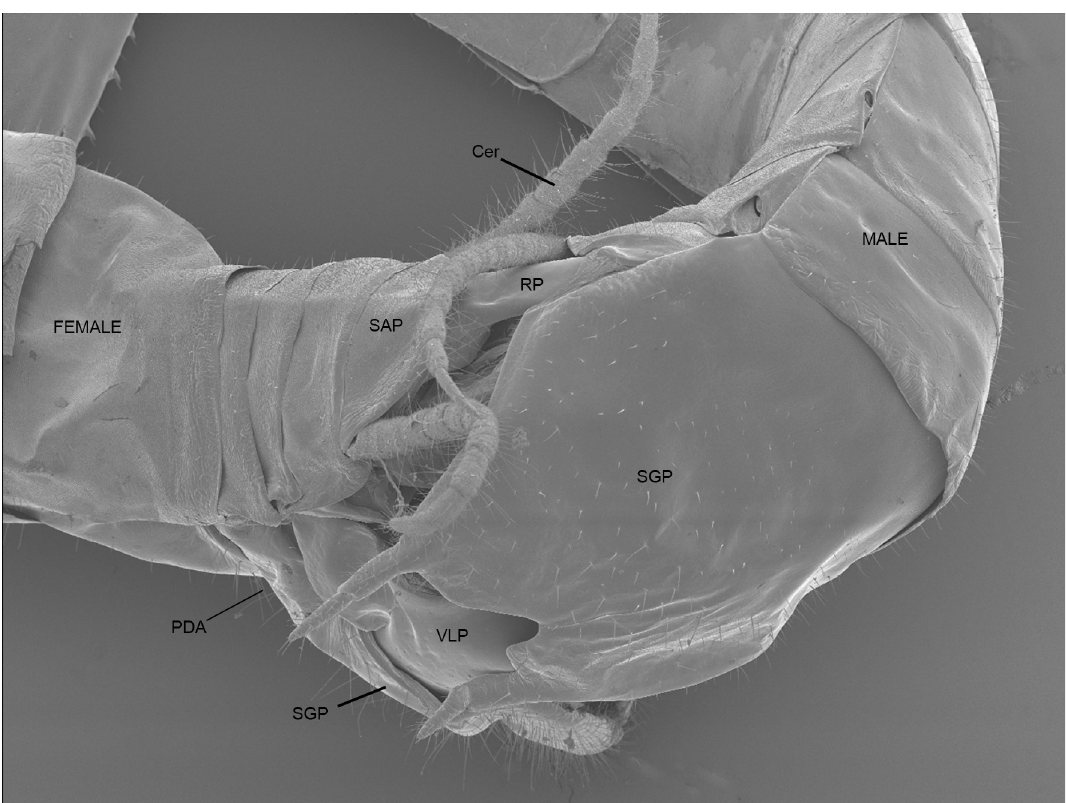
Fig 4. Scanning electron micrograph showing external interaction between male and female C . baldersoni genitalia in copula. Cer = cercus; PDA = processo distale (position of spines can be inferred from distention of female abdomen); RP = right phallomere; SAP = supra-anal plate; SGP = sub- genital plate; Sp = external tip of